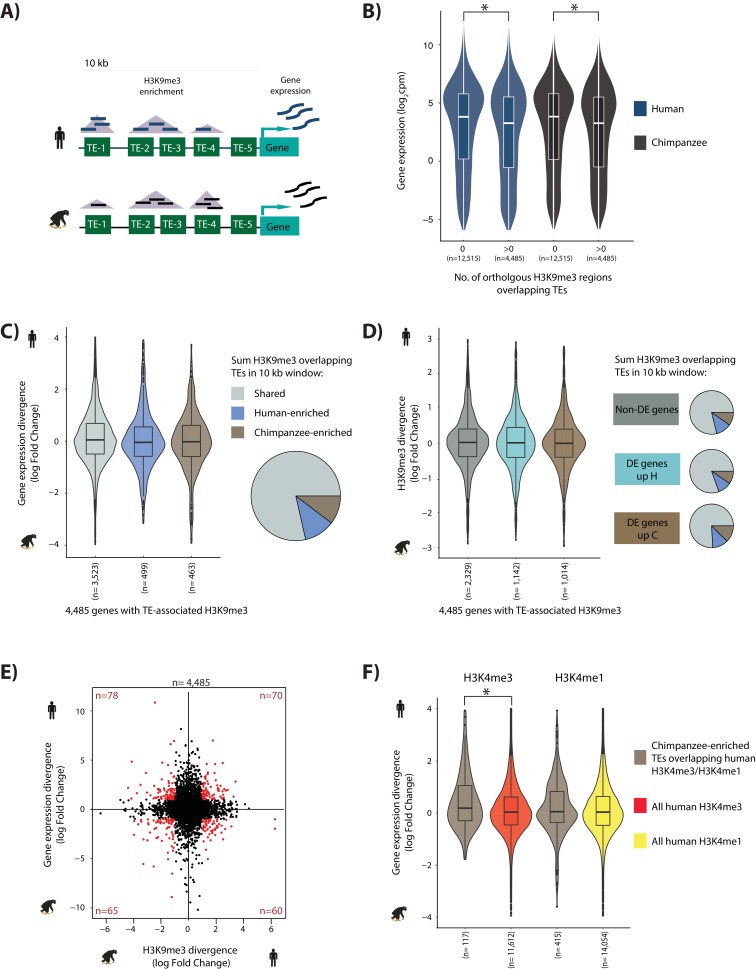
TE silencing divergence between species is not correlated with gene expression divergence.(A) Schematic representation of the experiment to determine how TE silencing affects nearby gene expression; orthologous TEs (green rectangles), orthologous H3K9me3 regions (purple triangles), human read counts (dark blue), and chimpanzee read counts (black). (B) Human and chimpanzee gene expression levels of orthologous genes with at least one TE present in a 10 kb window upstream of the TSS. Genes are categorized by the presence or absence of H3K9me3 regions overlapping TEs. (C) Gene expression divergence between human and chimpanzee at genes where TE silencing in the upstream 10 kb region is classified as Shared, Human-enriched or Chimpanzee-enriched. The proportion of genes associated with each TE silencing category is represented by the pie chart. (D) Stratification of genes based on differential expression status: genes that are similarly expressed in human and chimpanzee (dark grey), those that are up-regulated in human (turquoise), and those that are up-regulated in chimpanzee (dark brown) (FDR < 1%). The proportion of TEs marked by H3K9me3 in a 10 kb window upstream of the TSS in each gene category that are Shared, enriched in human, and enriched in chimpanzee are represented as pie charts. Box plots represent human-chimpanzee divergence of H3K9me3 enrichment overlapping TEs for each gene category. (E) Divergence in H3K9me3-mediated TE silencing between species versus neighboring gene expression divergence. Genes which have a H3K9me3 log fold divergence of >1 or <-1, and a gene expression divergence log fold change of >1 or <-1 are shown in red. (F) Inter-species gene expression divergence of orthologous genes closest to TEs overlapping H3K9me3 regions enriched in chimpanzee, and overlapping human H3K4me3/H3K4me1 regions identified in H1 hESCs. The closest orthologous genes to all human H3K4me3/H3K4me1 regions in H1 cells are used for comparison. Asterisk denotes a significant difference between categories (Wilcoxon-rank sum test; p<0.01). Also see Figure 6—figure supplements 1–10.